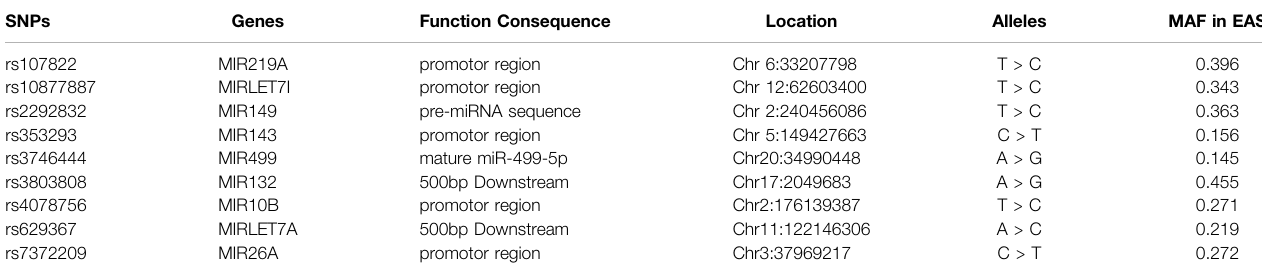
TABLE 1 | The information of the nine SNPs selected in the current study.